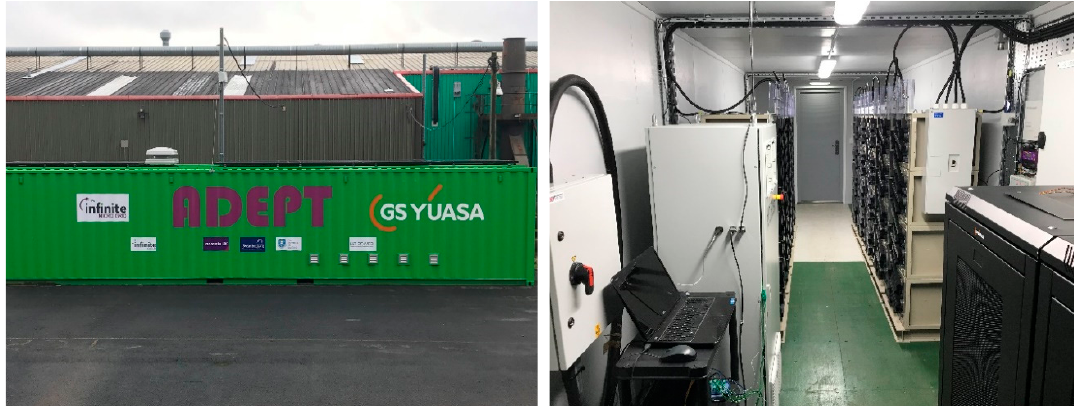
Figure 6. Battery storage cabinet of the ADEPT system (physical part).